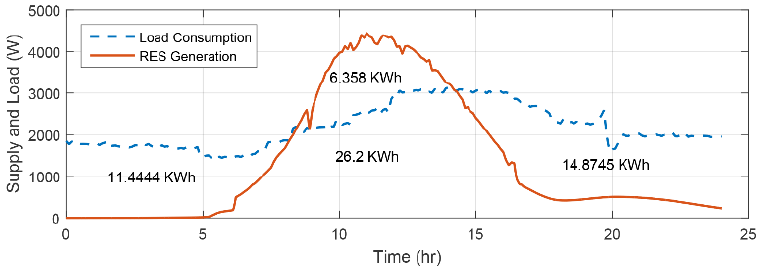
Figure 14. Residential load data of July 28th, 2016, in Dhahran.